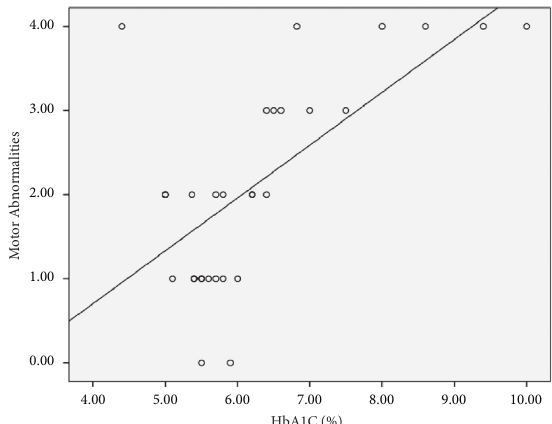
Figure 5: Scatter plot between motor abnormalities and